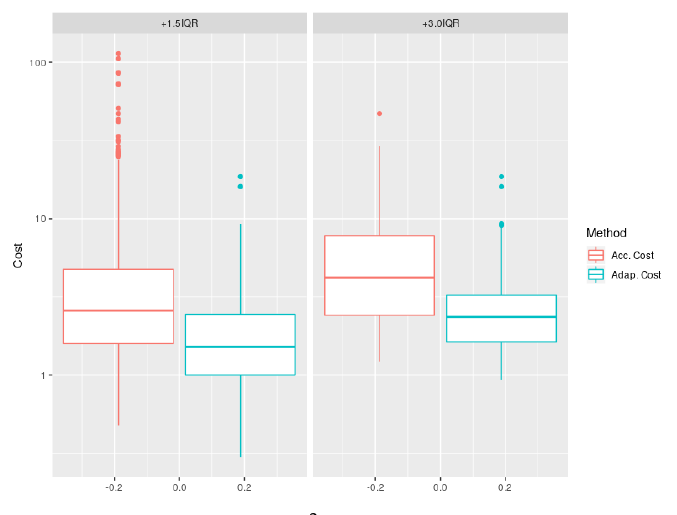
( b ) Outliers cost (MSE (m/s) 2 ) representation for each weather